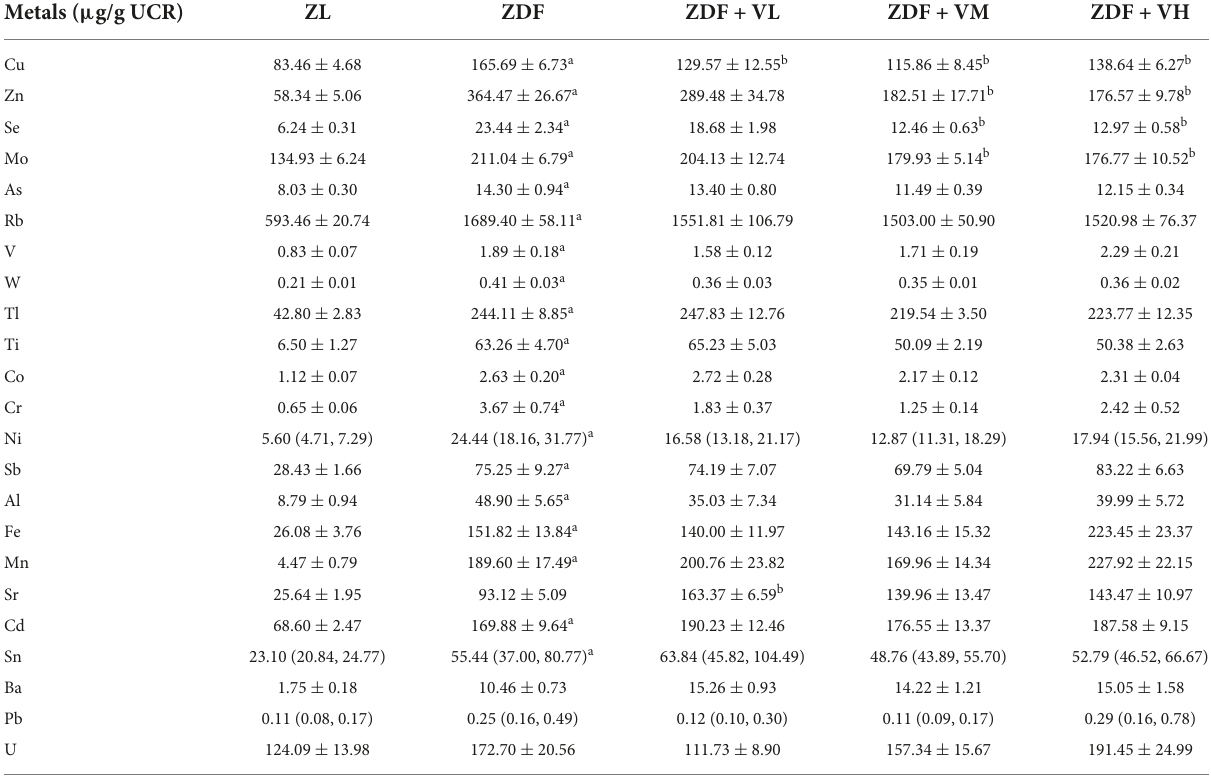
TABLE 5 Effects of 1,25(OH) 2 D 3 on urine metal concentration of Zucker rats in the seventh week of